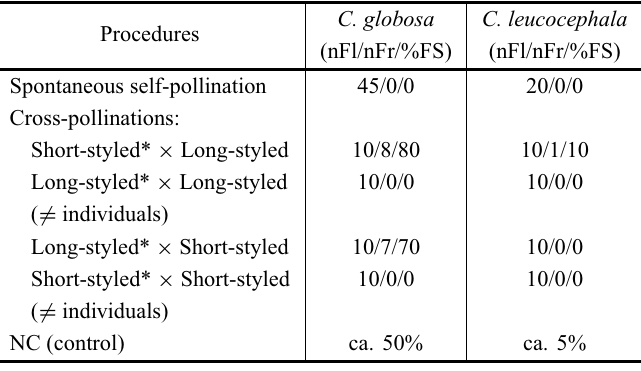
Pollination experiments in Cordia globosa and C. leucocephala in a Caatinga area, Pernambuco State, Brazil (nFl = number of flowers; nFr = number of fruits; %FS = percentage of fruit set), and estimated percentage of fruit set under natural conditions